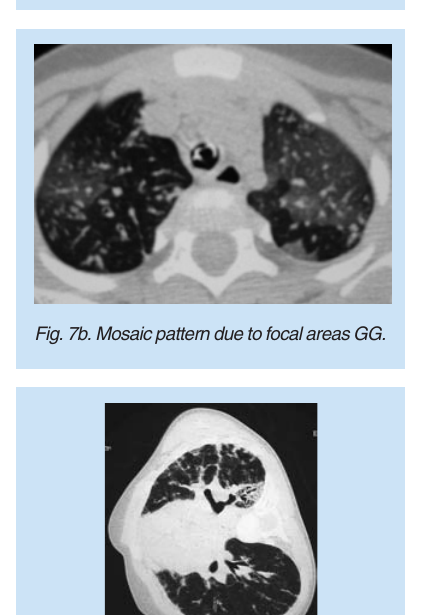
Table III.Air-trapping 3,4 Bronchiolitis obliterans